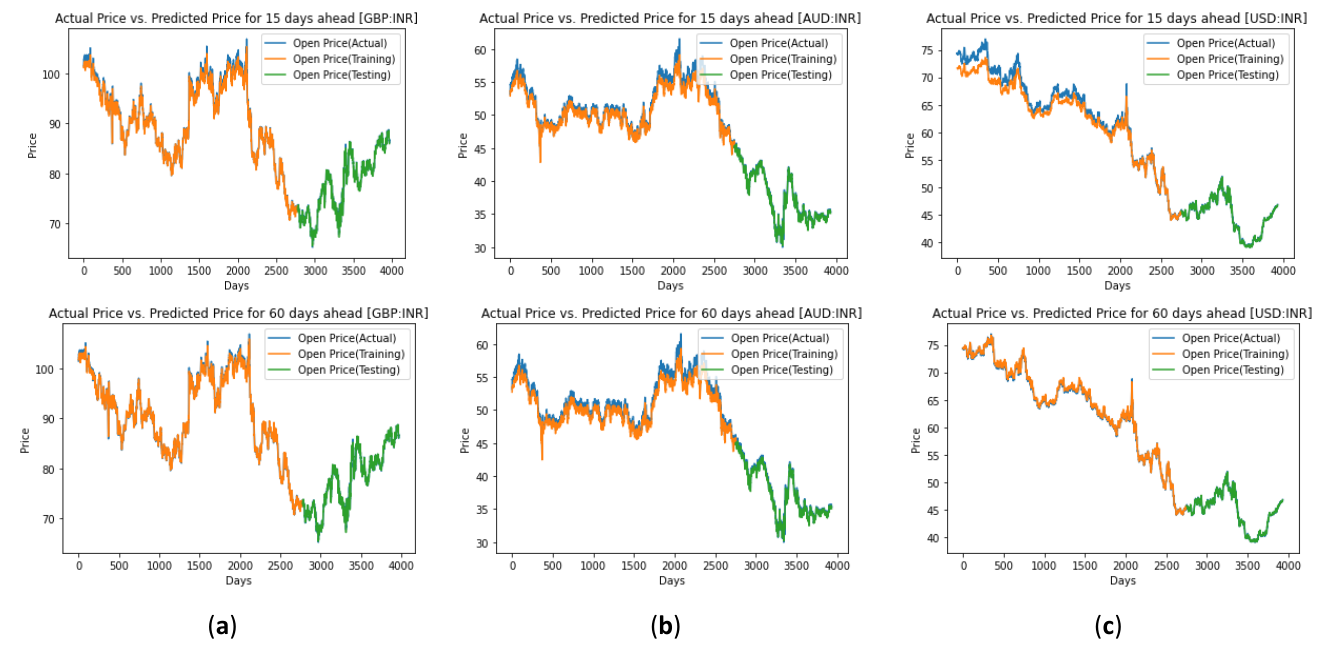
Figure 5. Short-term and long-term prediction graphs and MSE graphs using Bidirectional-LSTM for